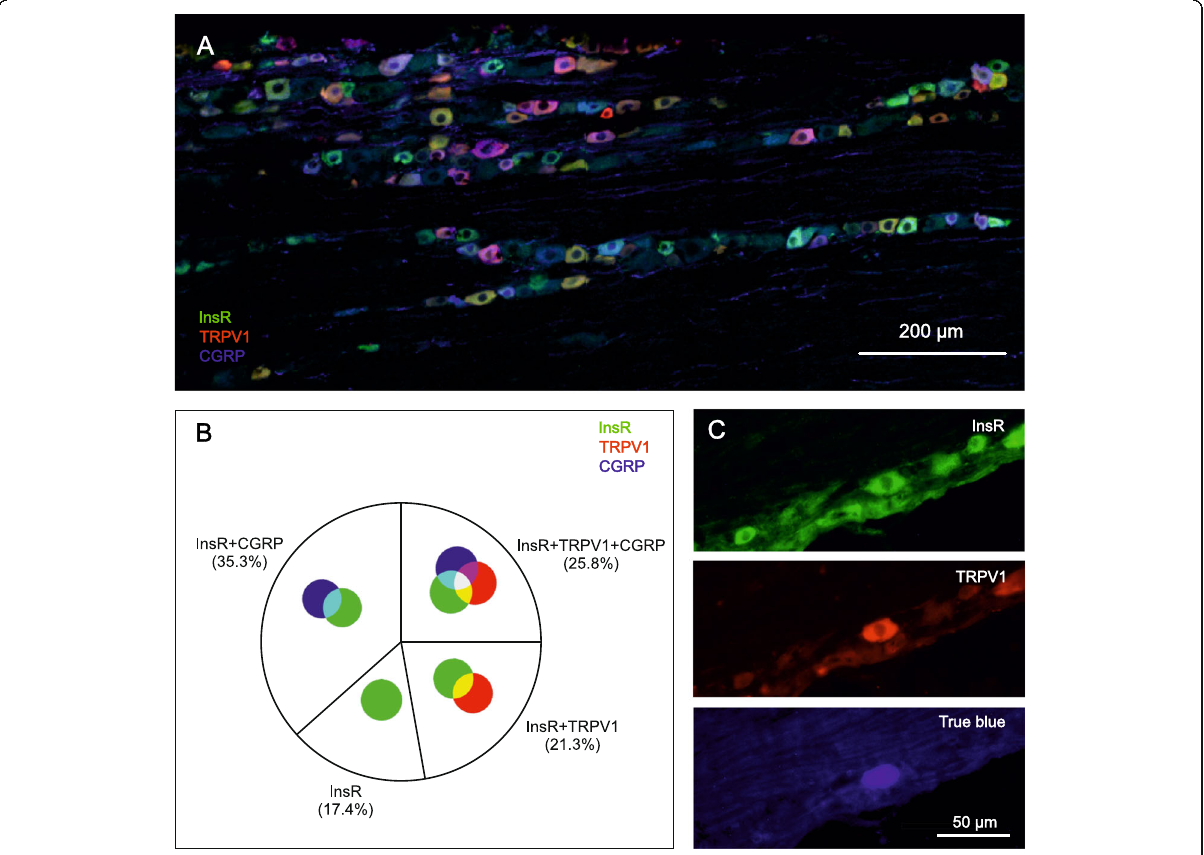
Fig. 5 Immunohistochemistry in rat trigeminal ganglion. ( A ) Trigeminal ganglion neurons in the ophthalmic division immunoreactive for insulin receptor (InsR), TRPV1 receptor and CGRP. ( B ) Coexpression of insulin receptor (InsR) with TRPV1 receptor and/or CGRP in trigeminal ganglion neurons. Colours representing insulin receptor-, TRPV1 receptor- and CGRP-immunoreactivities and their coexpressions indicated in B applies also to A. ( C ) A trigeminal ganglion neuron retrogradely labeled with True blue expresses both insulin receptor (InsR) and TRPV1